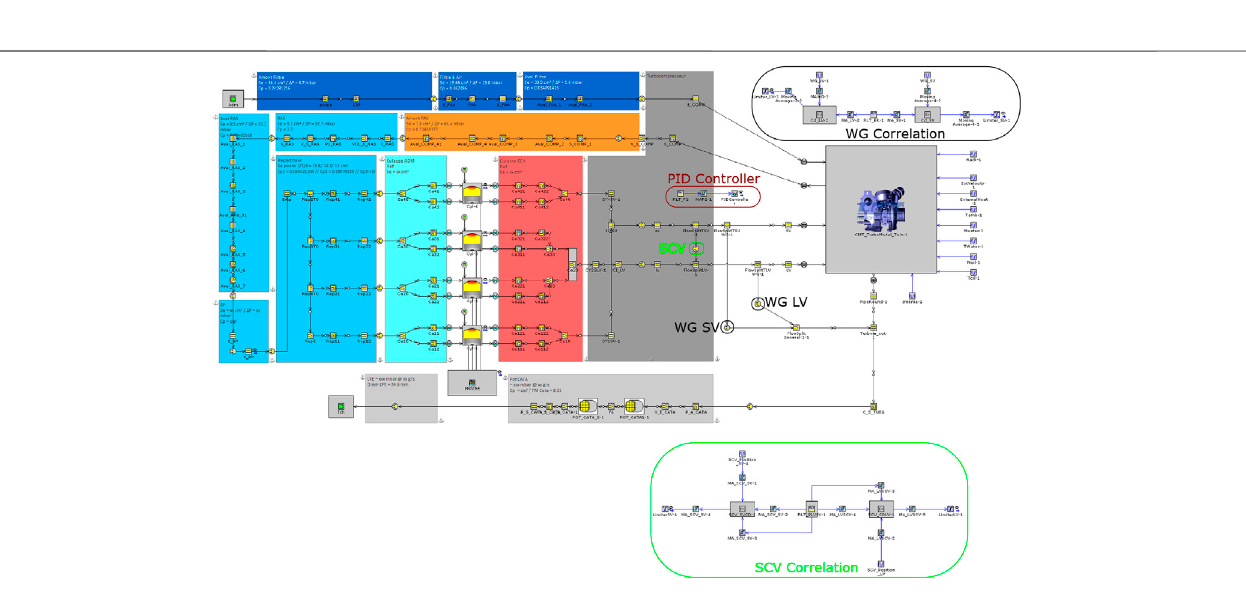
FIGURE 9 | GT-power model of the tested engine and its connection to the dual-volute turbine model.